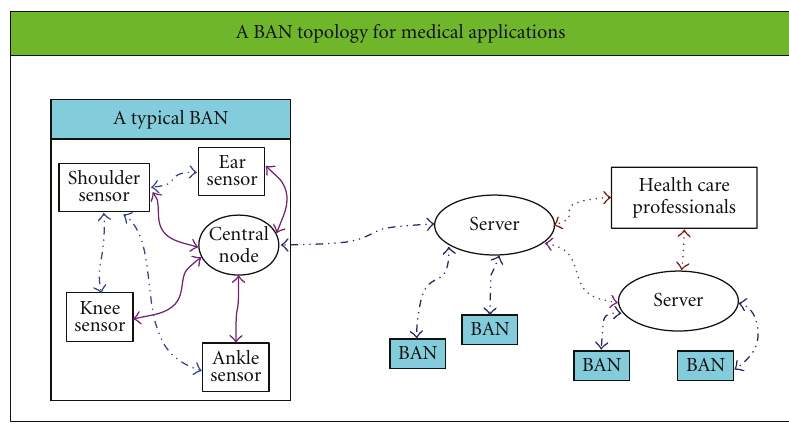
Figure 1: Model of a mobile health topology, consisting of various body area